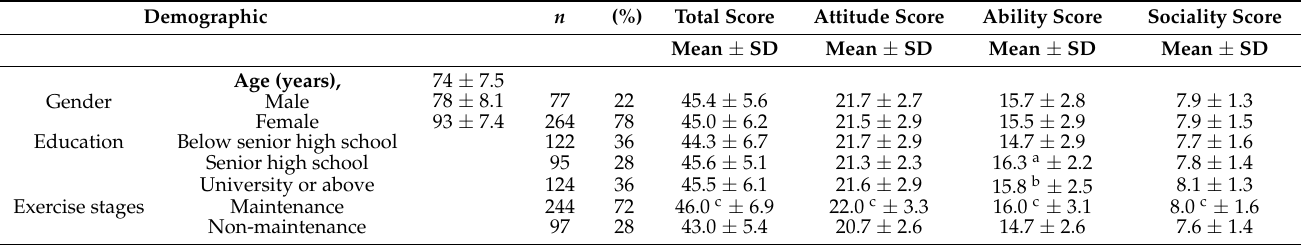
Table 1. Characteristics of participants ( n = 341).